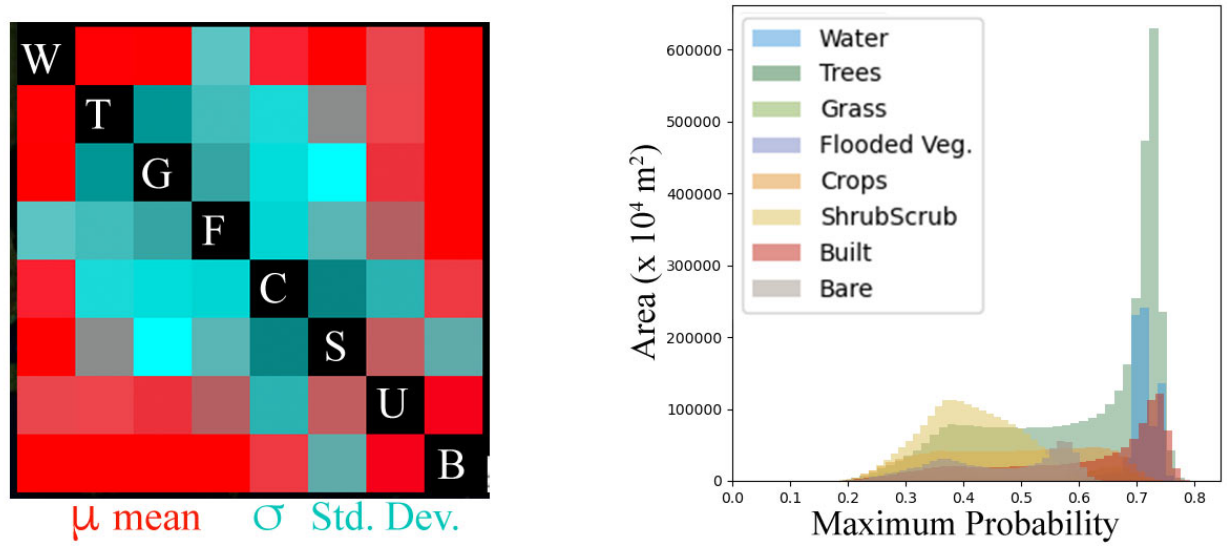
Figure 7. Aggregate spectral separability and maximum probability of classes. The generally more spatially homogeneous Water and Bare classes have high mean (m) separability (more red) with low variability (s) among the nine sites. Each has more variable separability (more cyan) with one other class. The Built class (U) also has high mean separability with all classes except Crops. The aggregate maximum probability histogram (right) shows similar distributions to those in Figure 5.